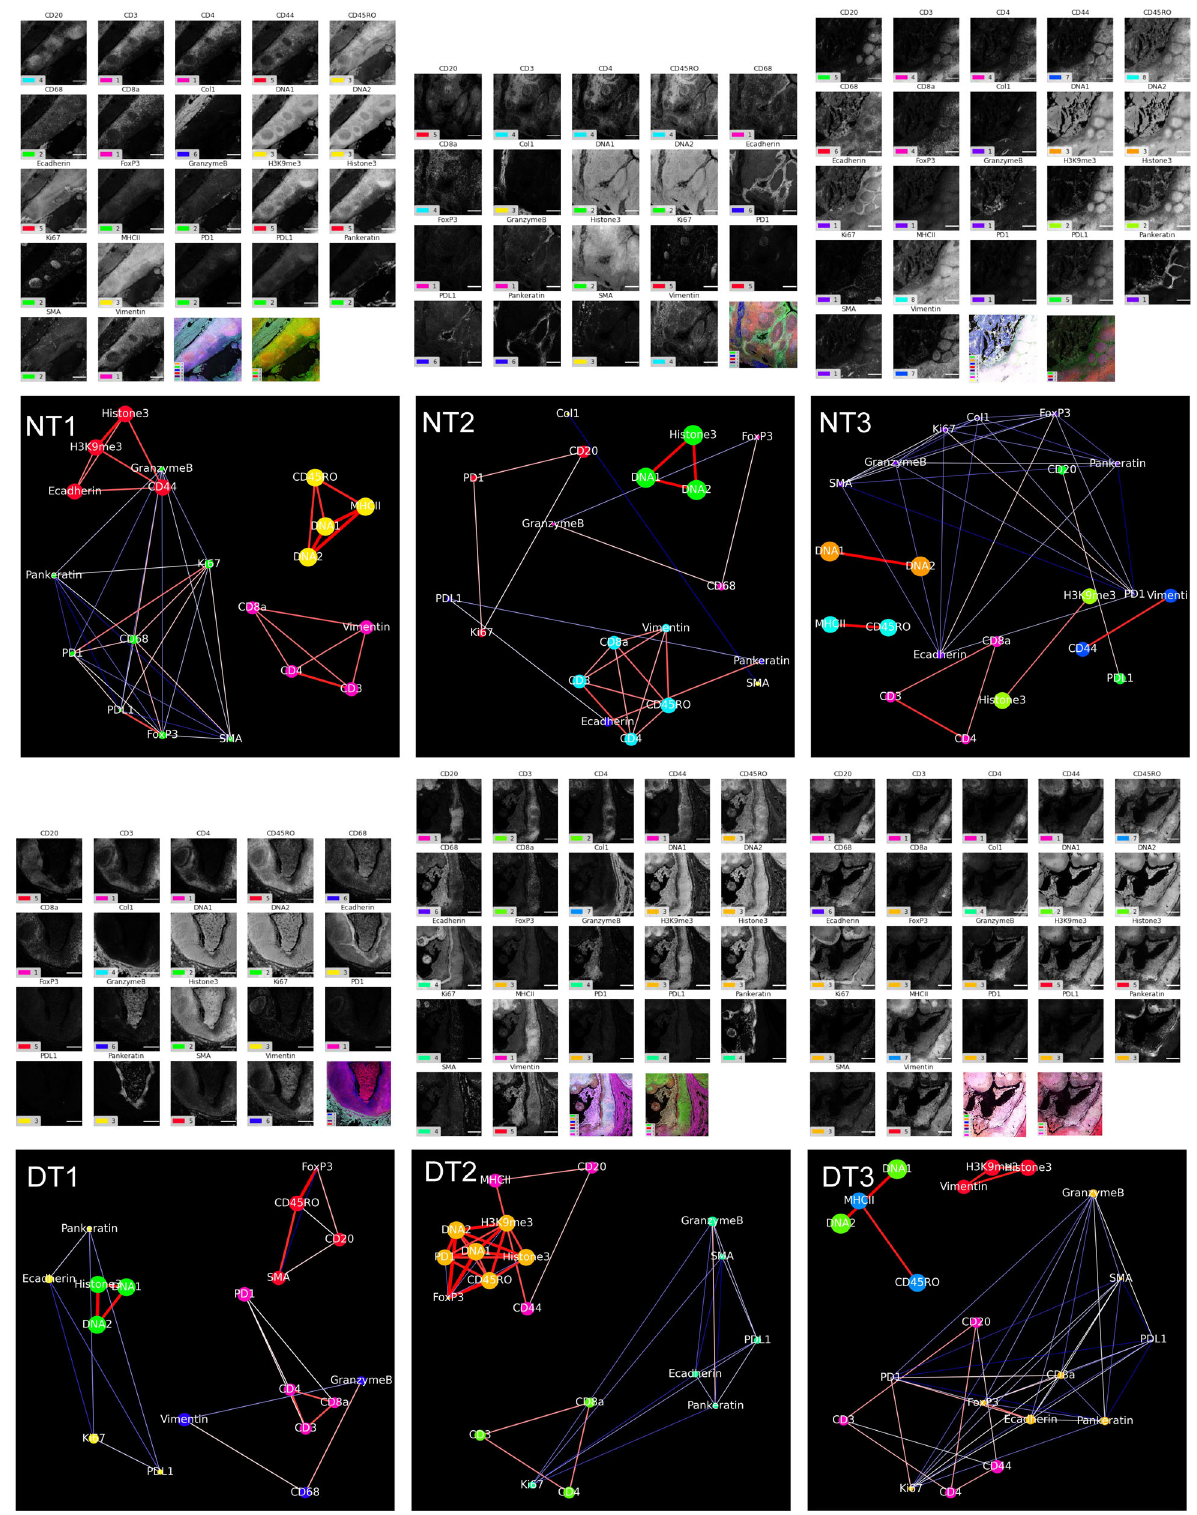
Fig. 5 Intra-cluster distance maps of markers that are expressed in single-cells from each anatomical cluster. Intra-cluster average spatial distance network maps are presented for single-cells from multiplexed markers inside anatomical clusters for each multiplexed image pair in healthy and diseased tonsils. The number of markers is 19 – 22. The color of nodes represents the corresponding cluster of the marker images. Here, only markers within the same cluster determined by anatomical clustering are linked. The red edges between network nodes show short average distances, while blue ones indicate relatively distant marker pairs (scale bar 500 µ